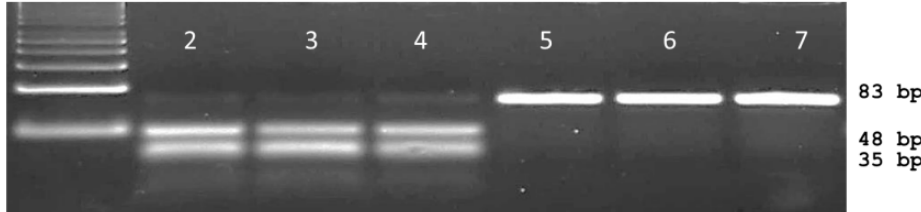
Figure 2. Typical dPACS profiles for wild S264 and mutant G264 psb A Amaranthus retroflexus individuals. Lane 1: 50 bp DNA ladder, lanes 2, 3, 4 Ple I restricted wild S264 haplotype; lanes 5, 6 and 7 Ple I unrestricted mutant G264 haplotype.